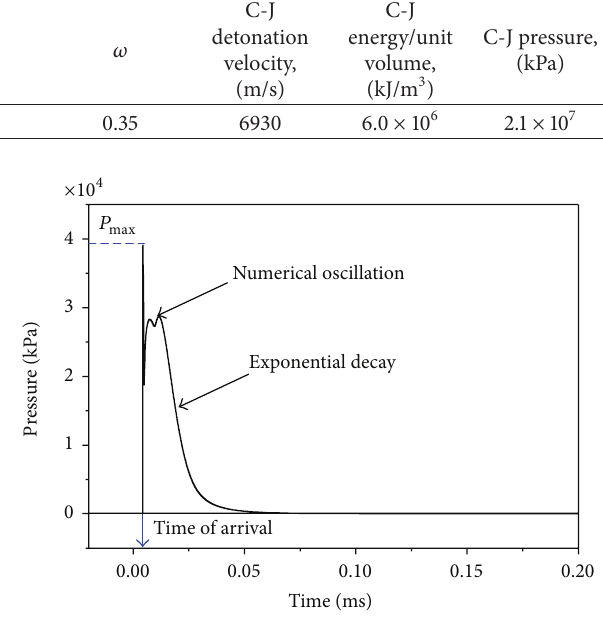
Figure 3: History of the air-blast induced pressure at the stand-off distance of 30